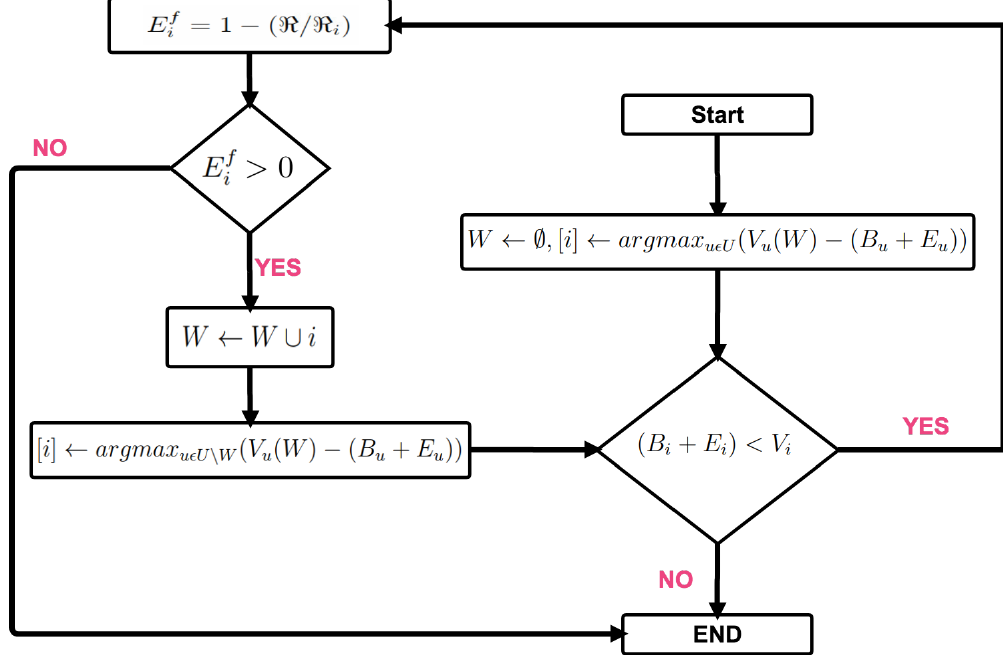
Figure 8. Winner selection in user